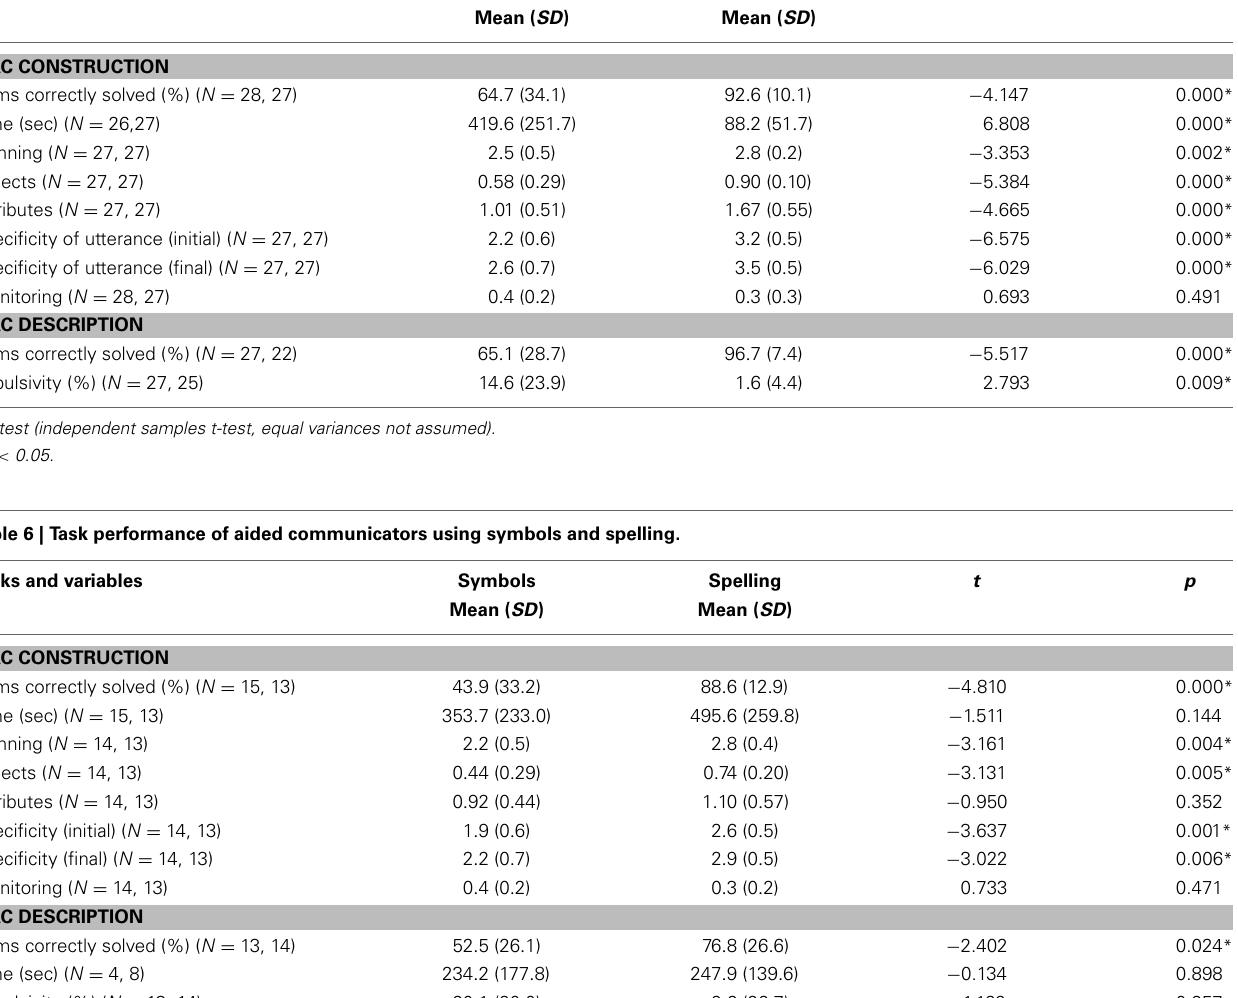
Table 5 | Task performance of aided group and comparison group. Tasks and variables Aided